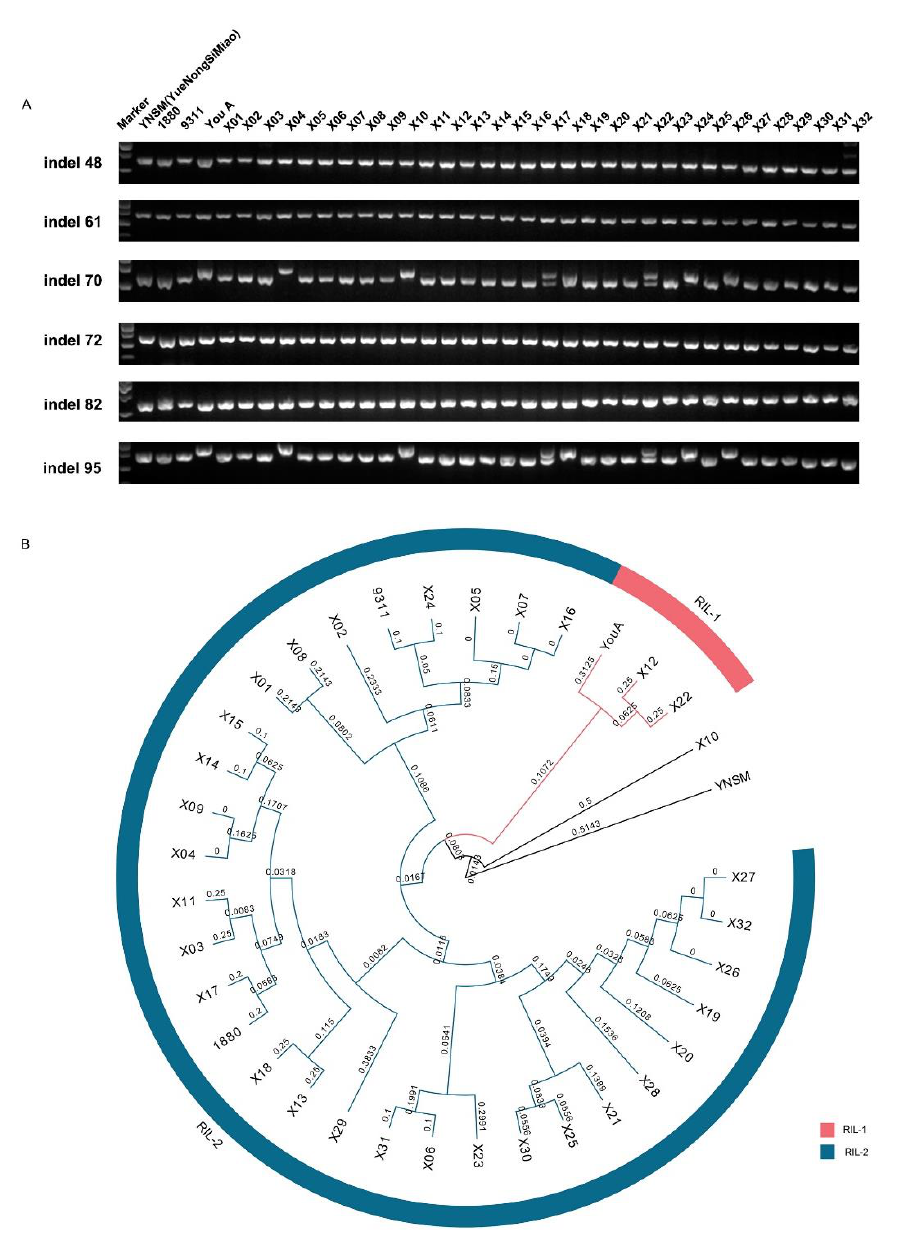
Figure 5. PCR amplification and phylogenetic tree of the recombinant inbred line (RIL) population. ( A ) PCR amplification of the RILs. M: DL2000, DNA marker. YueNongSiMiao (YNSM) was used as a control. ( B ) Phylogenetic tree of the RILs and 18 indica varieties by the UPGMA dendrogram using InDel markers. Dark blue and orange represent indica varieties and RILs, respectively. The numbers in the phylogenetic tree represent evolutionary distances of the tree structure below this